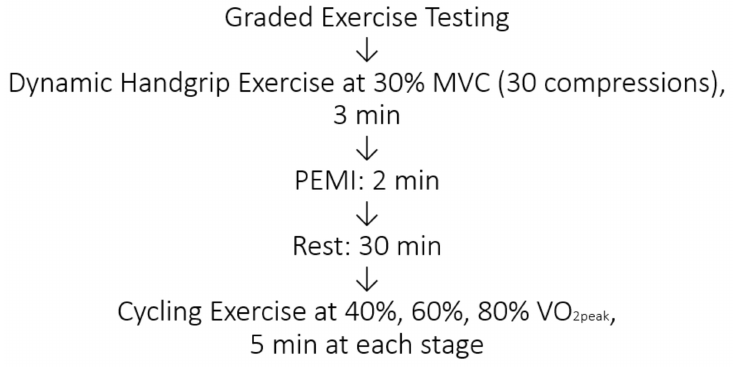
Figure 1. Experimental